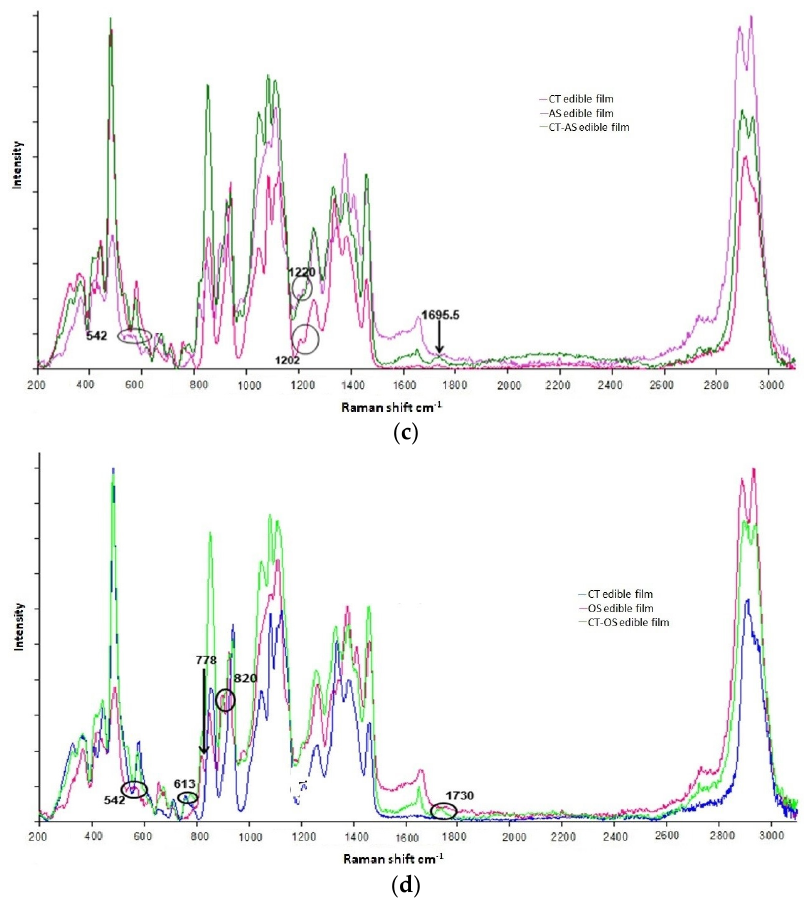
Figure 3. Raman spectroscopy of edible films based on starch, CH and CH ‐ starches mixtures (1:3 ratio, w / w ): ( a ) CT ‐ starch mixtures; ( b ) solid line CT, dashed line WS, dotted line CT–WS; ( c ) solid line CT, dashed line AS, dotted line CT–AS; ( d ) solid line CT, dashed line OS, dotted line CT–OS.